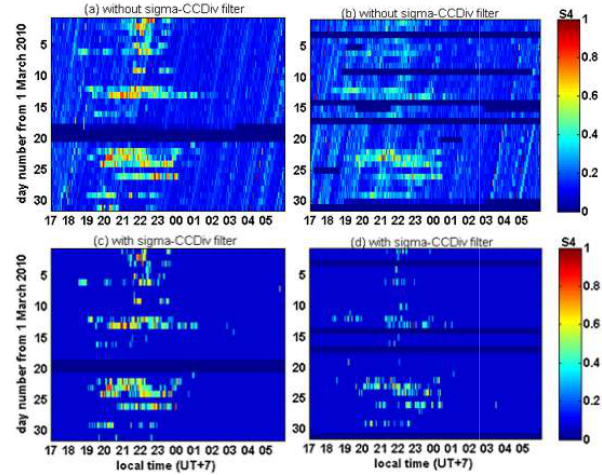
Fig. 4. A comparison between the plot of scintillation occurrences . Comparison between plot of scintillation occurrences without sigma . Comparison between plot of scintillation occurrences without sigma-CCDiv filter Figure 4 . Comparison between plot of scintillation occurrences without sigma3 without the sigma-CCDiv filter for (a) Bandung and (b) Pontianak for (a) Bandung and (b) Pontianak data, and with the filter for (c) 4 for (a) Bandung and (b) Pontianak data, and with the filter for (c) Bandung and (d) Pontianak Bandung and (d) Pontianak data, and with the filter for (c) Bandung and (d) Pontianak data. 5